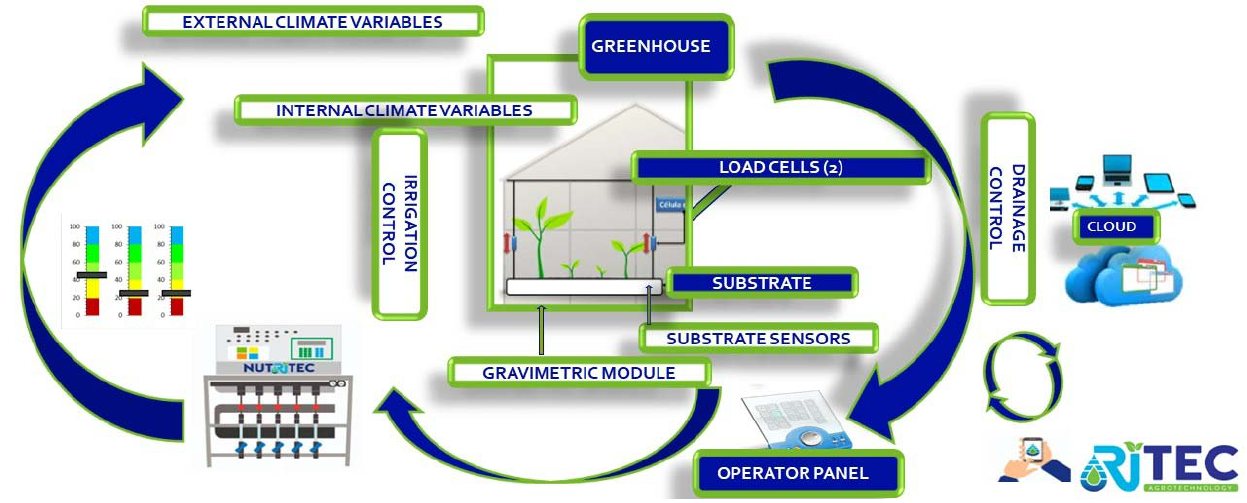
Figure 8. Gravimetric control system architecture. www.ritec.es (accessed on 10 March 2023)